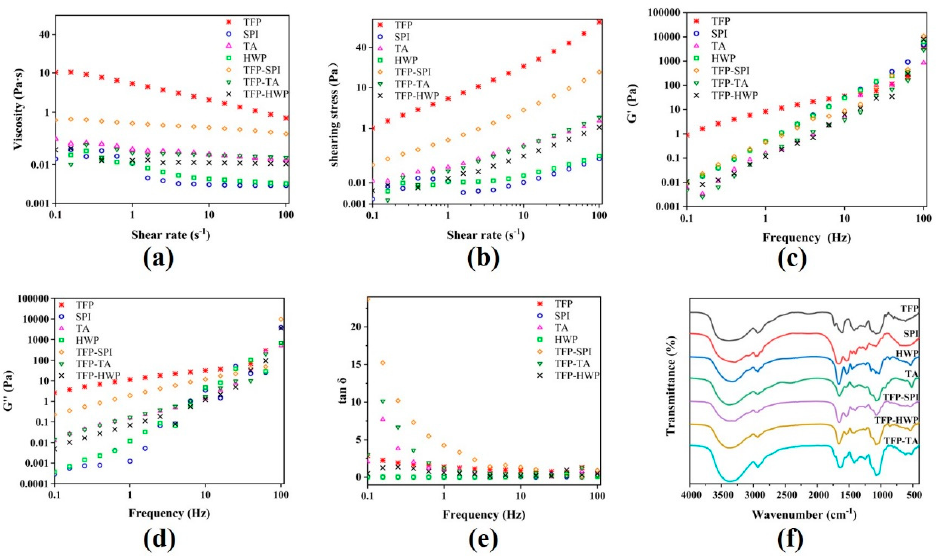
Figure 6. Rheological property images ( a – e ) and FTIR images ( f ) of different raw materials and com- pounds.